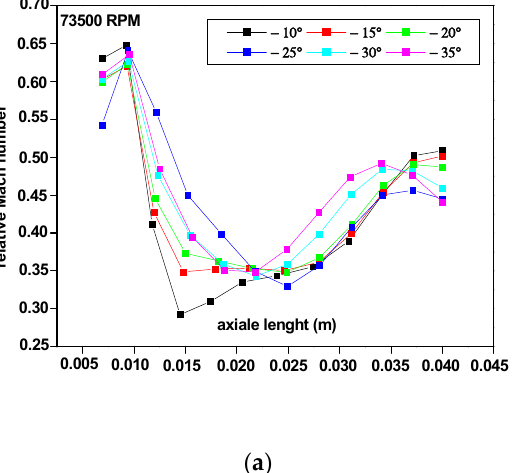
Figure 19. Relative Mach number for different deviation blade angles at 50% rotation speed. The variation is negatively confirmed for the other design cases by falling off the output work magnitude. The variation of the relative Mach number along the axial direction of the flow for different deviation blade angles at a rotational speed of 75% and 100% are successively presented in Figure 20a,b.